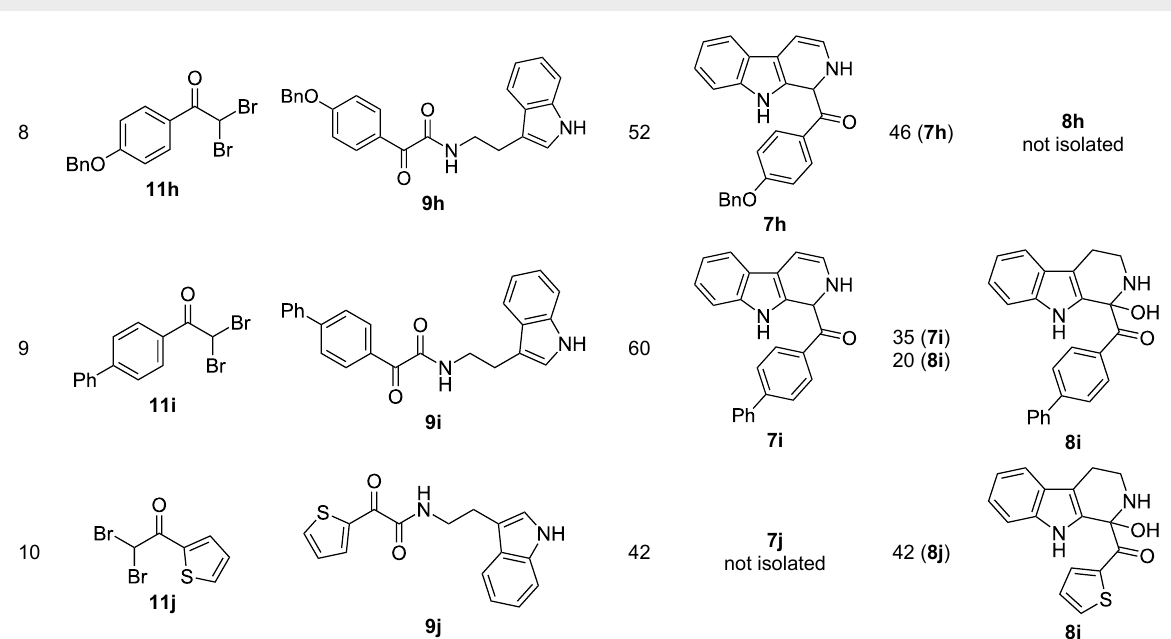
Table 2: Synthesis of dihydro- β -carbolines a .